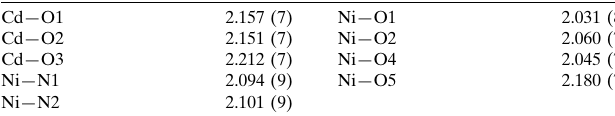
Selected bond lengths (A˚